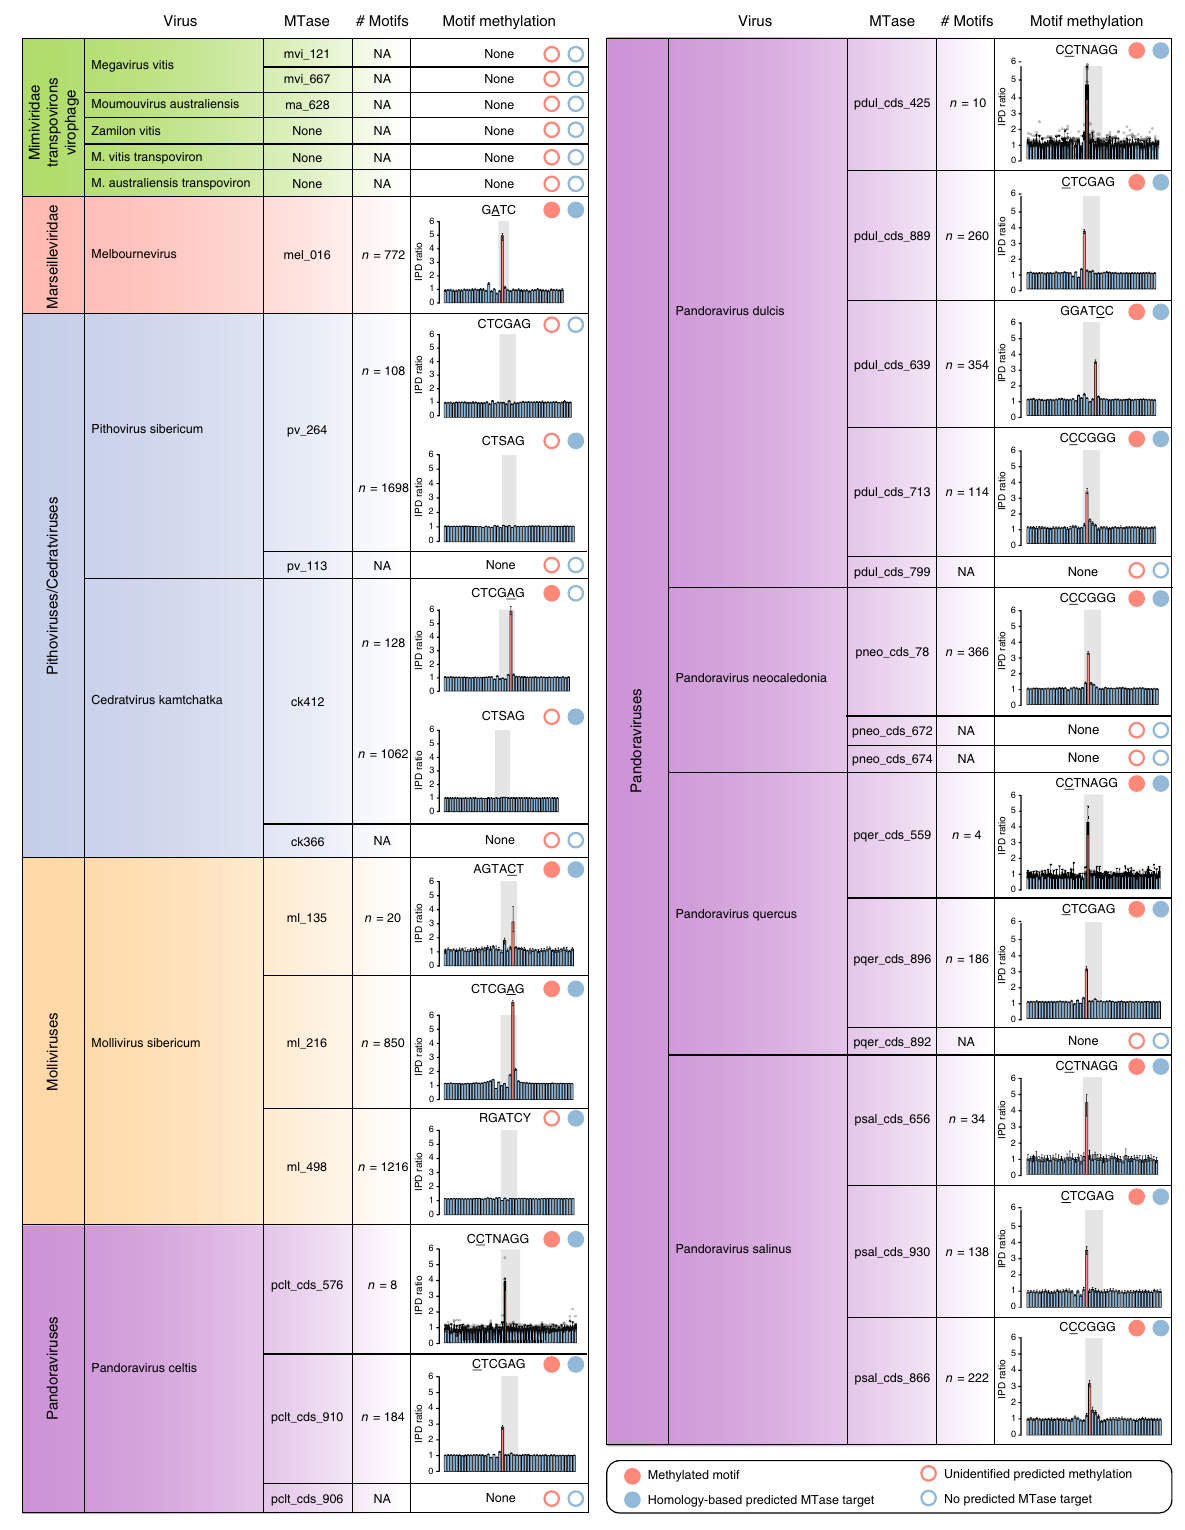
Fig. 1 Encoded MTases and targeted methylated motifs in the giant viruses ’ genomes. The encoded DNA MTases of each virus are shown along with the number of occurrences of the predicted targets (if any) on both strands of the cognate genomic sequence. Modi fi ed nucleotides within the motifs are underlined. Red circles indicate methylated motifs experimentally veri fi ed from SMRT data ( fi lled circles) or with unidenti fi ed predicted methylation (empty circles). Likewise, predicted ( fi lled circle) and not predicted (empty circle) targets based on sequence homology of the encoded MTase are shown using blue circles. Bar graphs correspond to the median IPDr pro fi les of the motifs (gray region) and the surrounding 20 nucleotides on each side. Each bar displays the median IPDr value and a 95% con fi dence interval (error bars) based on 1000 bootstraps. These statistics are derived from the number of occurrences ( n ) of the motifs in each genome. Red bars correspond to positions with signi fi cantly high IPDr values. Individual data points are displayed for viruses with n ≤